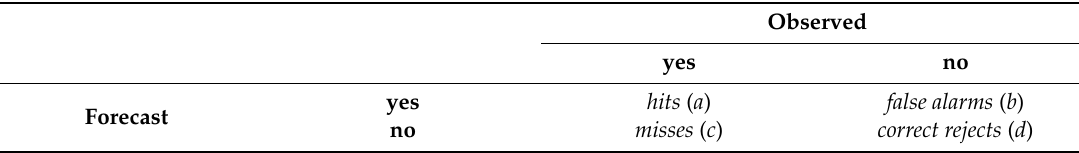
Table 2. Contingency table.